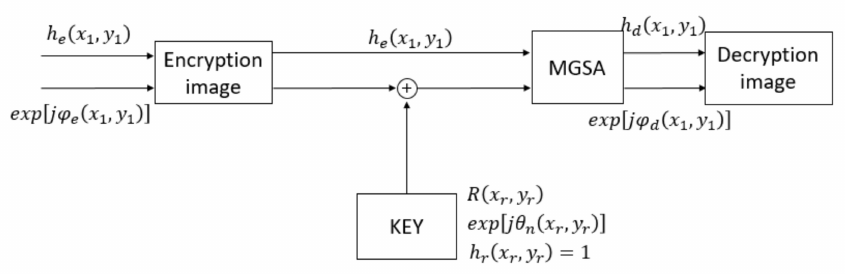
Figure 6. Decryption flow